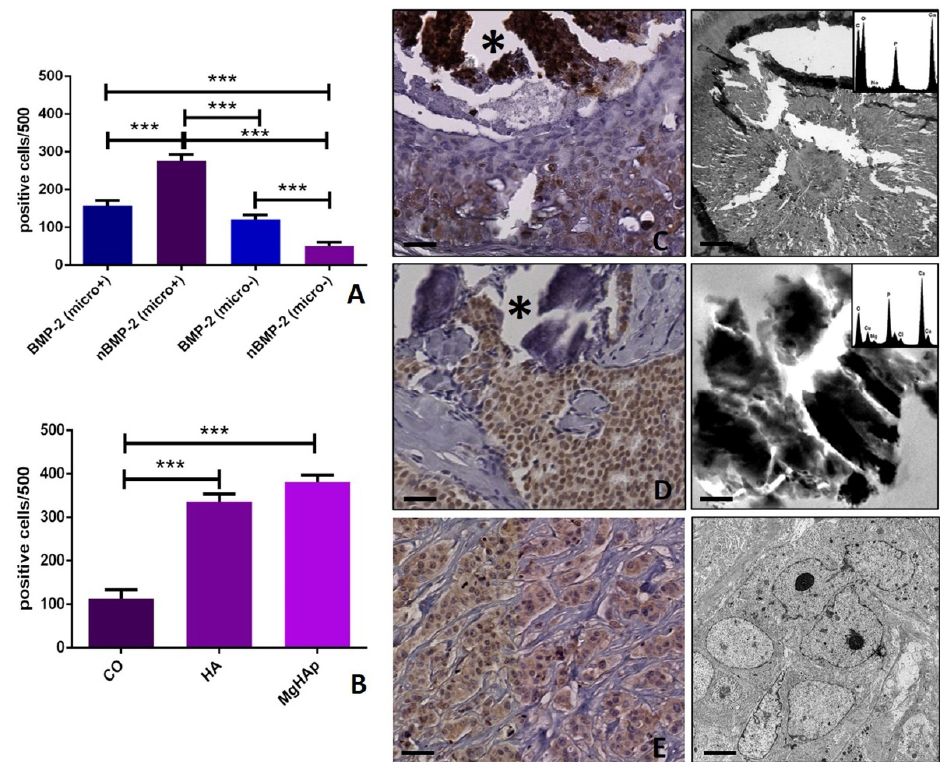
Figure 3. Cytoplasmic and nuclear BMP-2 in breast microcalcifications. ( A ) The graph displays the expression of cytoplasmic and nuclear BMP-2 in breast tissues with or without microcalcifications. ( B ) The graph shows the expression of nuclear BMP-2 in breast tissues with calcifications made of calcium oxalate (CO), hydroxyapatite (HA) or magnesium-substituted hydroxyapatite (Mg–HAp). The elemental composition of microcalcification has been performed on a para ffi n serial section by transmission electron microscope and energy dispersive X-ray microanalysis apparatus. ( C ) The image shows some cytoplasmic BMP-2-positive breast cells in an infiltrating breast carcinoma next to a microcalcification (the asterisk). The transmission electron microscope and energy dispersive X-ray microanalysis show that microcalcification is made of HA (spectrum). ( D ) Numerous nBMP-2-positive cells in an infiltrating breast carcinoma close to a microcalcification (the asterisk). The transmission electron microscope and energy dispersive X-ray microanalysis show that microcalcification is made of Mg–HAp. ( E ) Cytoplasmic and nuclear BMP-2-positive breast cells in an infiltrating breast carcinoma without microcalcifications. The electron micrograph shows a cluster of infiltrating breast cancer cells. The scale bar represents 100 µ m for each immunohistochemical image. Transmission electron microscope scale bars: A, 0.2 µ m; B, 0.2 µ m; C, 5 µ m. (* p ≤ 0.05, ** p ≤ 0.01, *** p ≤ 0.001, **** p ≤ 0.0001).